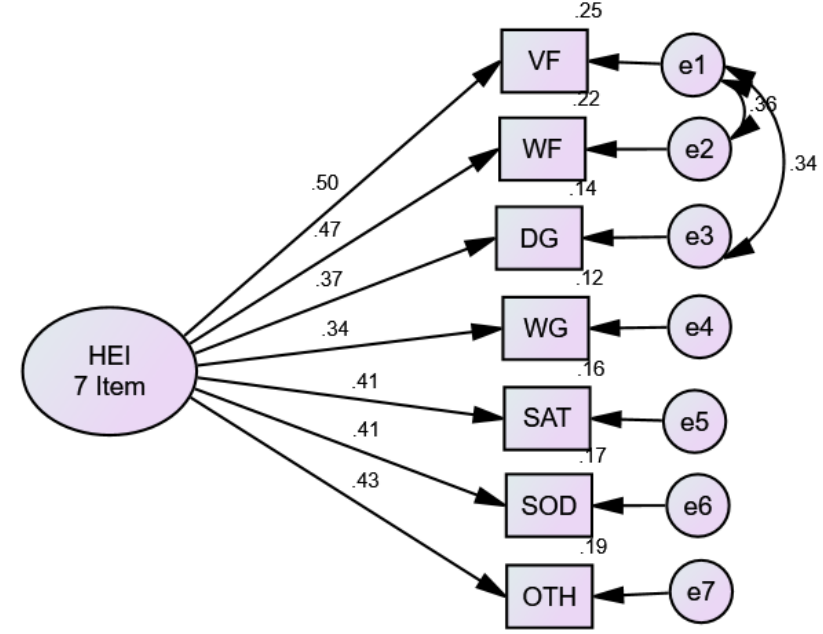
Figure 5. Baseline confirmatory factor analysis model for HEI-C. HEI = total HEI-C; VF = total vegetables and fruit; WF = whole fruit; DG = dark green and orange vegetables; WG = whole grains; SF = saturated fats; SOD = sodium; OTH = Other foods; e# = error terms. Squares are measured variables; circles are latent variables. Table 2. Model Comparison for Reduced (7-Item) HEI-C Models.